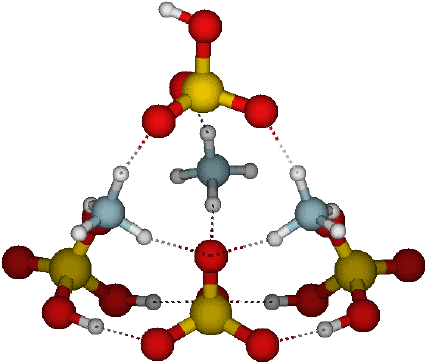
Fig. 1a. Most stable (H 2 OS 4 ) 2 ((CH 3 ) 2 NH) 2 cluster structure, Yel- low, red, white, blue, and brown spheres represent sulfur, oxygen, hydrogen, nitrogen and carbon atoms, respectively.